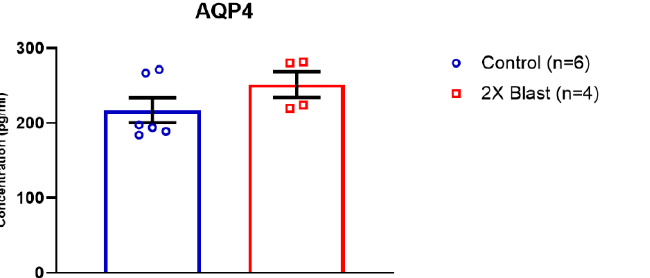
Figure 3. Plasma concentration of AQP4 following double blast exposure. Histogram representing the plasma concentration of AQP4 15 days following an explosive ‐ driven double blast exposure, Ctl, n = 6, Blast, n = 4.